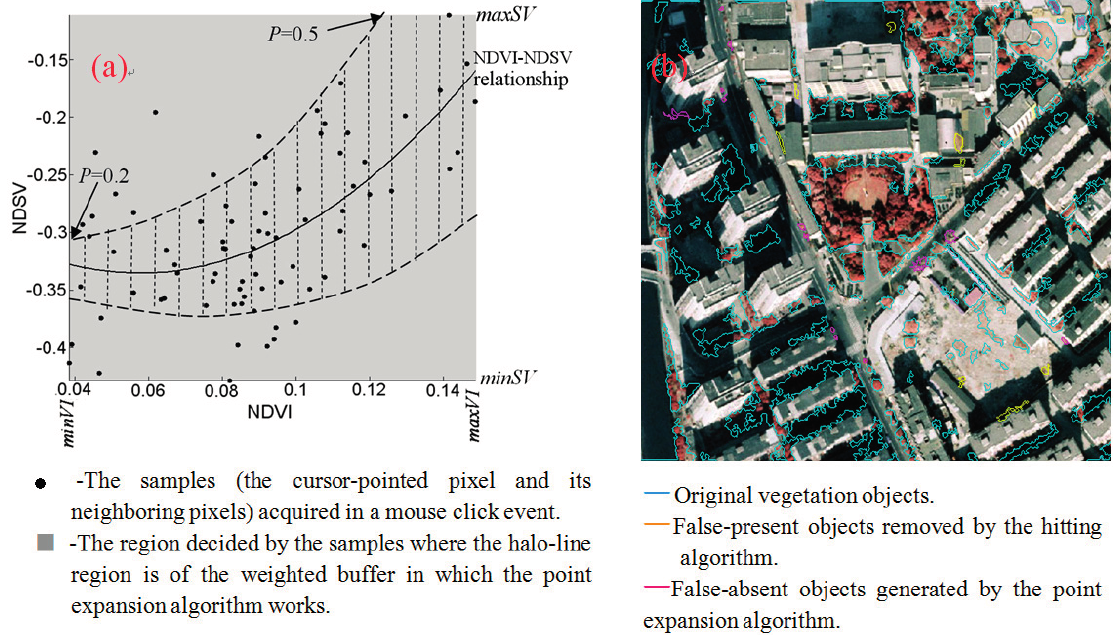
Figure 6. An example of refining vegetation objects. ( a ) A case-fitting process at a mouse click event. Weight P will make the width of the buffer gradually narrowed (in this